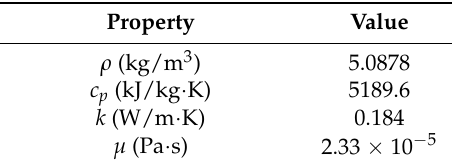
Table 2. He properties at 40 bar and 80 ◦